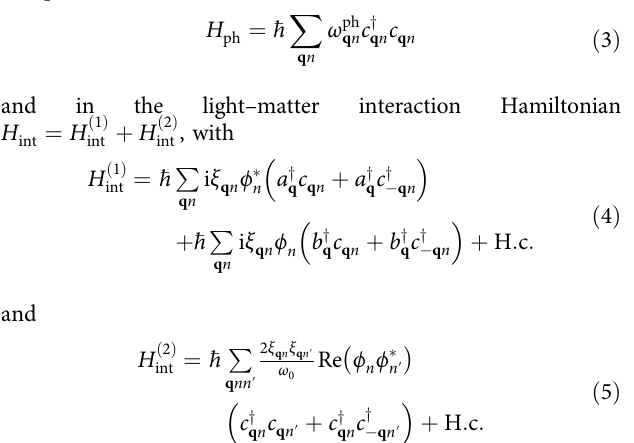
P ¼ Þ encodes 3 exp ð i q (cid:2) e q j j ¼ 1